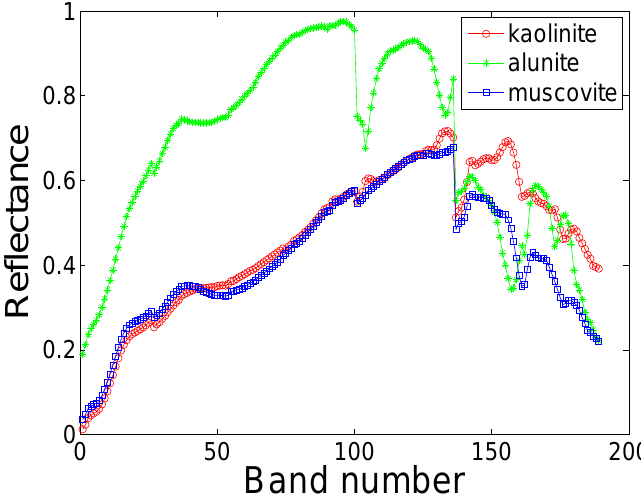
Figure 4. Extracted endmembers of